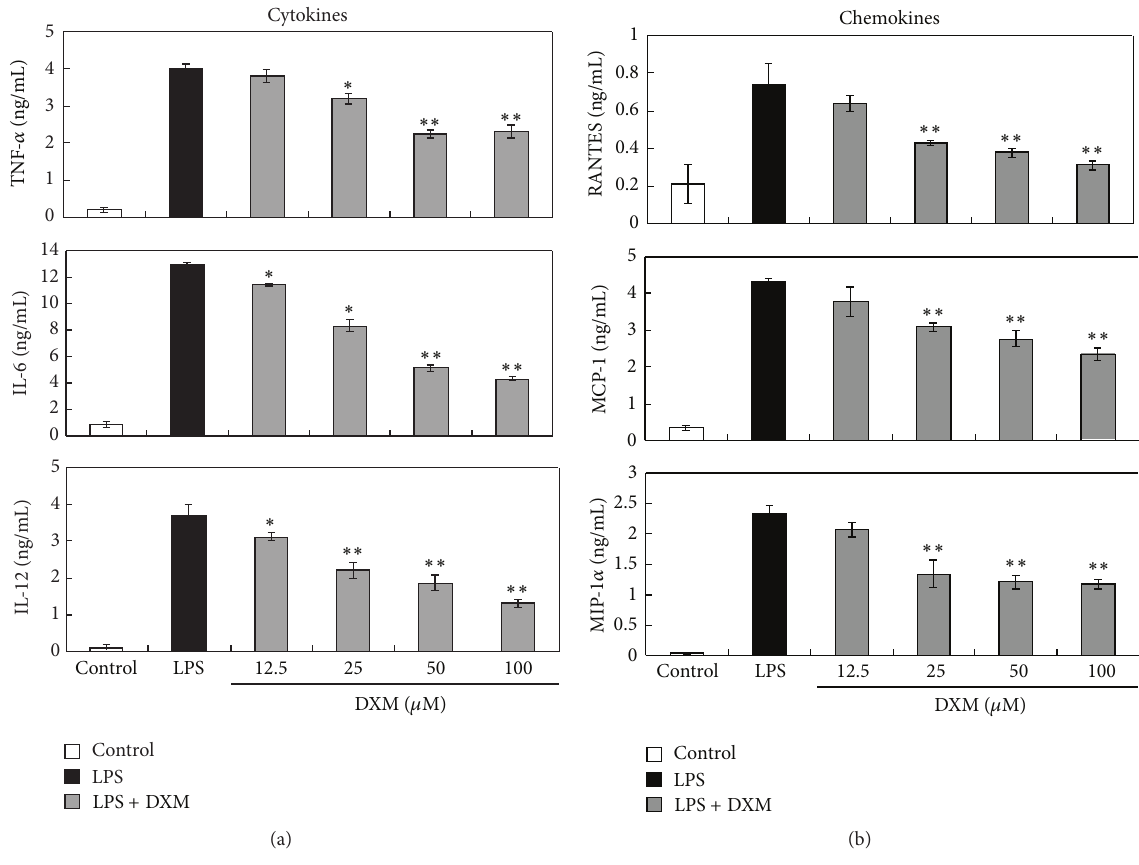
Figure 2: DXM impaired the release of cytokines and chemokines from LPS-stimulated BMDCs. Immature BMDCs were stimulated with 100ng/mL LPS with or without DXM. The control group was treated with PBS alone. Culture supernatants were collected after 18h (4h for TNF-alpha and RANTES), and cytokines and chemokines were quantified by ELISA. Data are presented as the means ± SD of samples from three wells. Significant differences between DXM-treated and untreated LPS-activated BMDCs are shown with asterisks ( ∗ 𝑃 < 0.05 , ∗∗ 𝑃 < 0.01 ). All data are representative of three independent experiments.